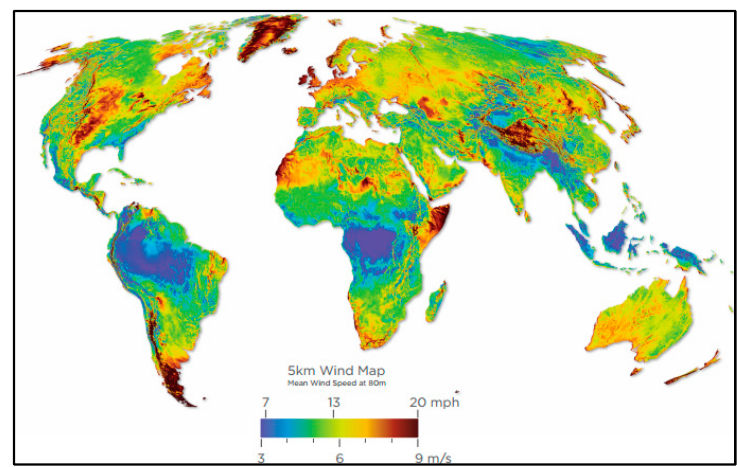
Figure 9. Global wind speed map [96].